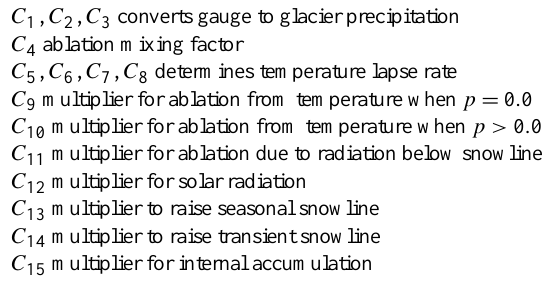
Table 2. Mass balance